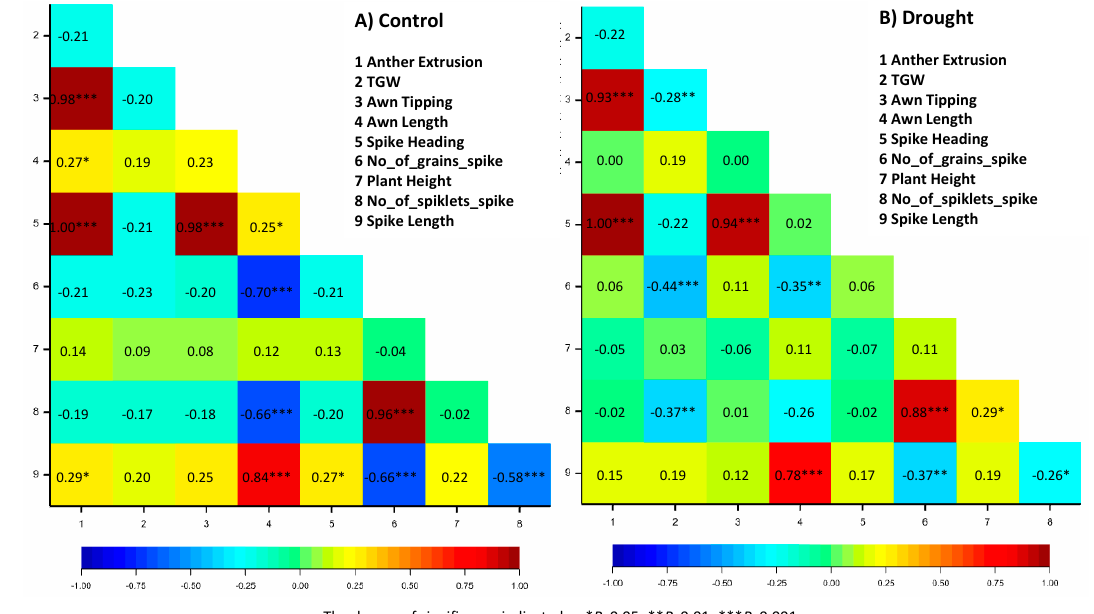
Figure 3. Correlations matrix among the studied traits in barley genotypes ( A ) under control, and ( B ) under drought stress. The degree of significance is indicated as * p , 0.05; ** p , 0.01; *** p , 0.001; ns: not significant.